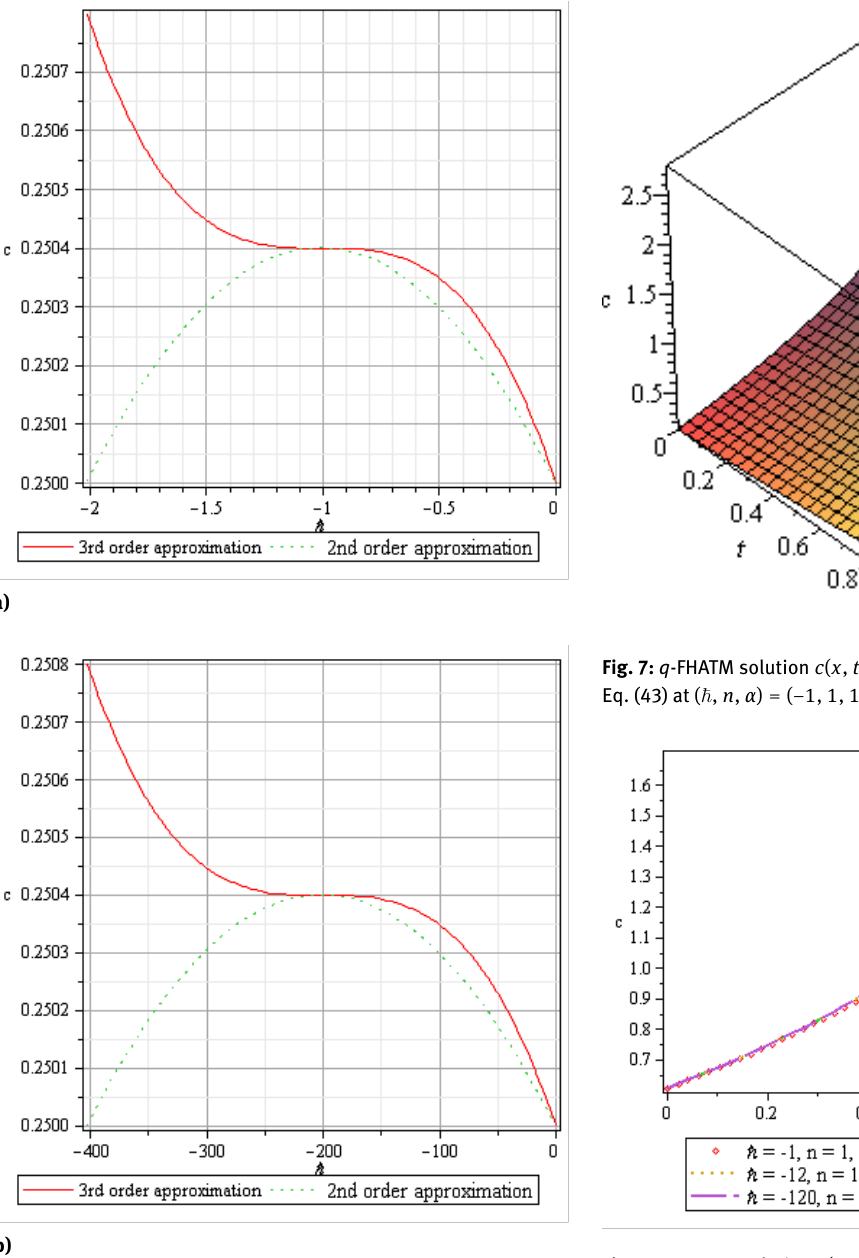
Fig. 6: (cid:126) -curves at x = 0.02, t = 0.5 and β = 1 ; (a) for n = 1 , (b) for n = 200 .